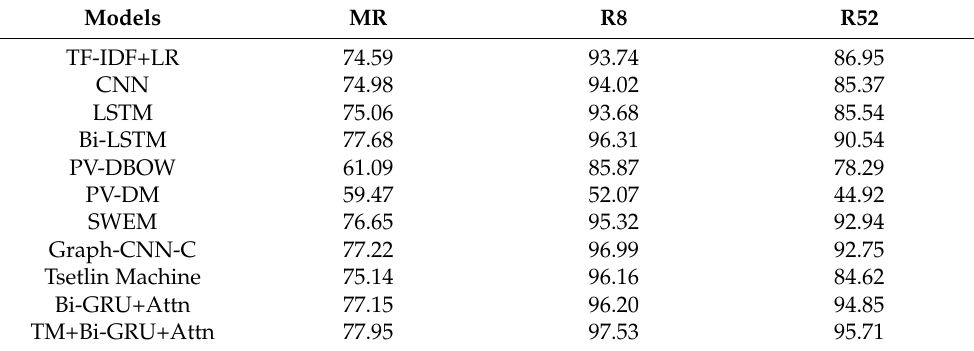
Table 3. Performance of the proposed model (TM+Bi-GRU+Attn) with selected baselines.